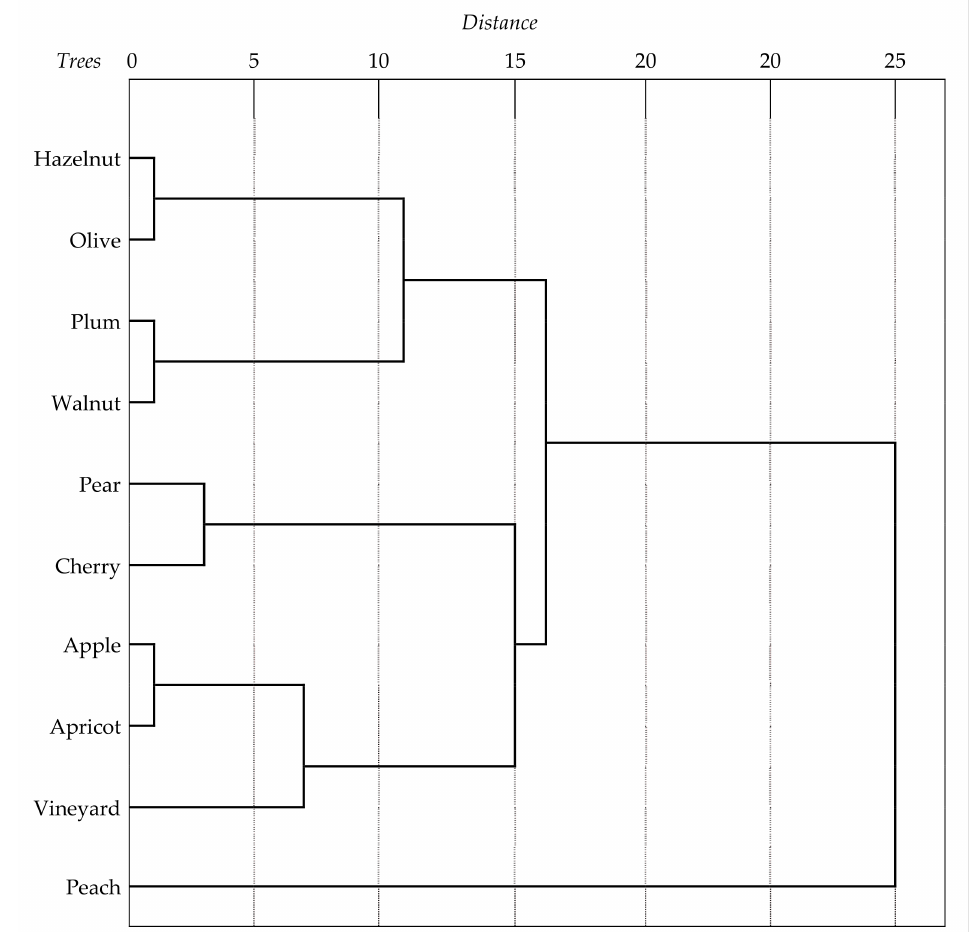
Figure 4. Dendrogram of the chemical and energy characteristics of the different types of